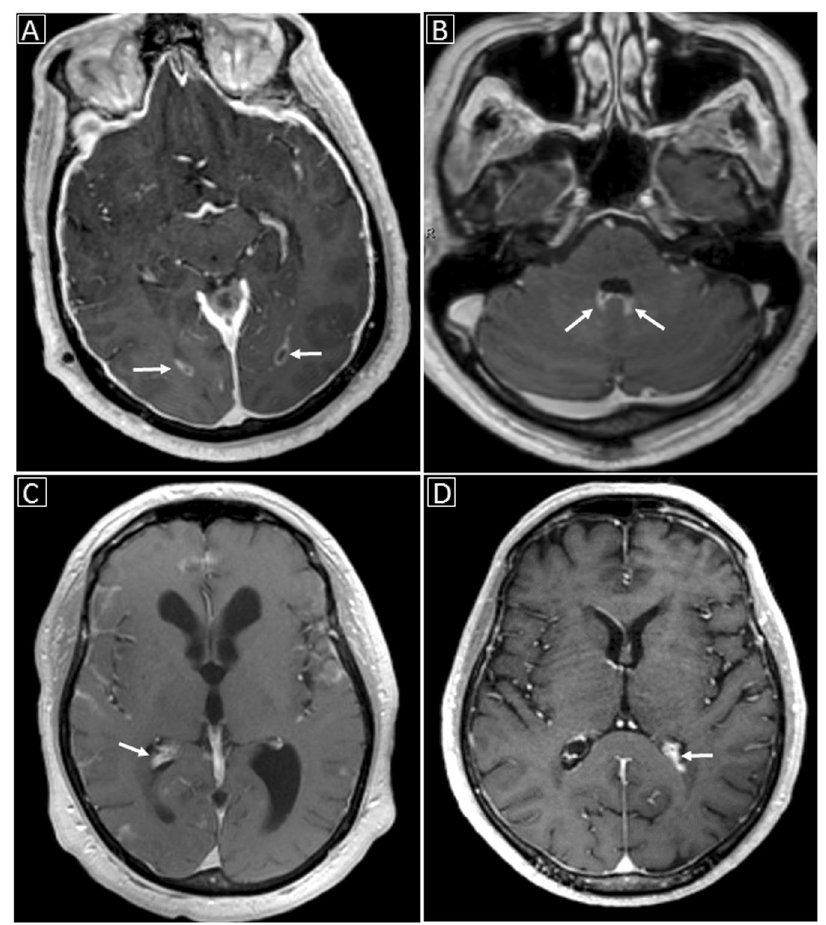
Figure 2. Examples of ventricular involvement in CNS cryptococcosis: ( A ) Abnormal ependymal enhancement along the occipital horns of the lateral ventricles bilaterally (white arrows) on enhanced T1-weighted image; ( B ) Abnormal ependymal enhancement along the posterior aspect of the fourth ventricle with probable associated choroid plexitis (white arrows); ( C ) Choroid plexitis of the right lateral ventricle (white arrow) with hydrocephalus; ( D ) Left lateral ventricular choroid plexitis (white arrow).